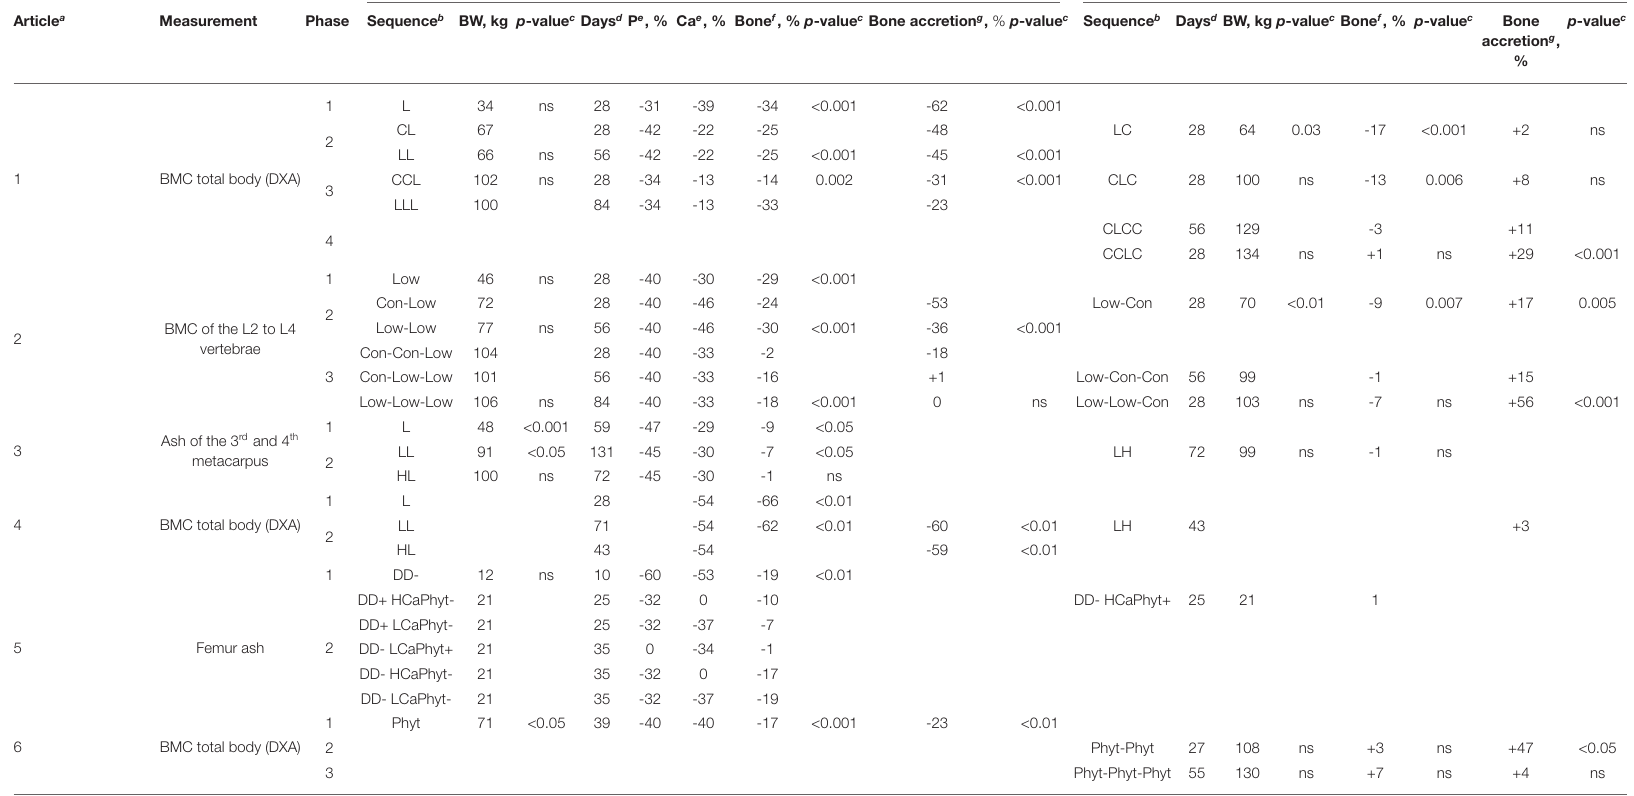
TABLE 3 | Effect of depletion–repletion strategy on bone mineralization of growing